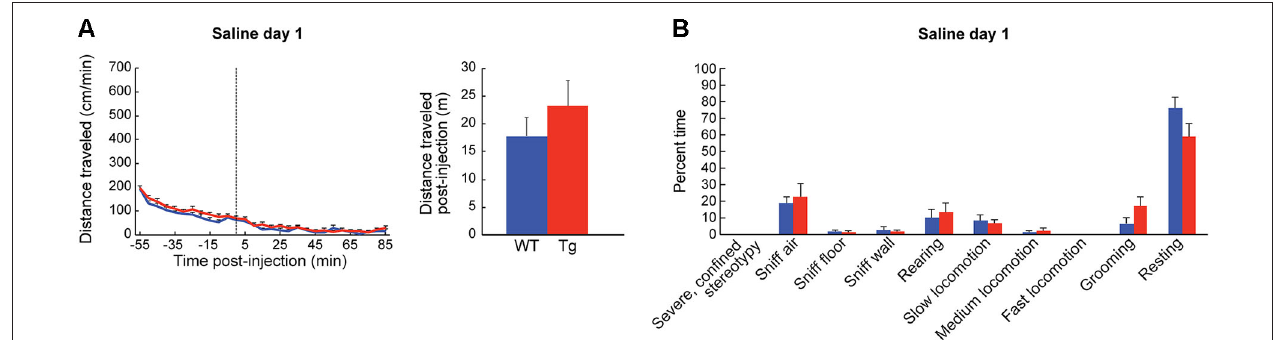
time 0. The total distance traveled during an 85-min post-injection period is shown in the bar graph. (B) Observational ratings of behaviors, averaged for 50 and 80 min post-injection observation points, were equivalent in transgenic mice and sibling controls.